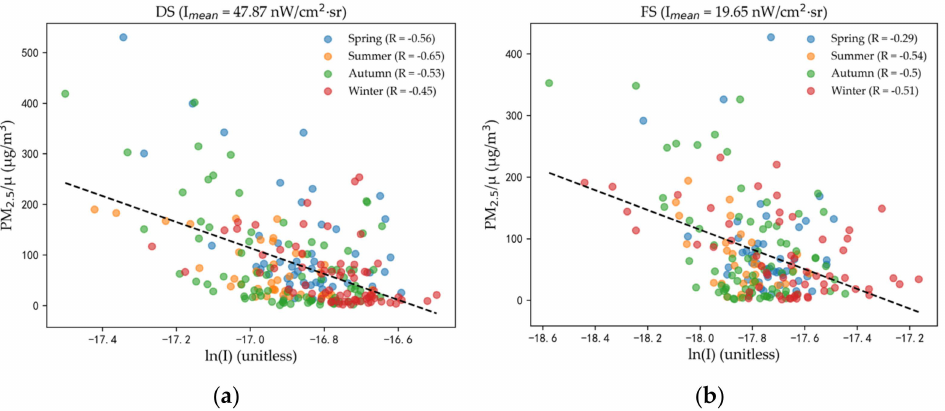
Figure 3. Scatter plots of PM 2.5 / µ and ln(I): ( a ) is the DS site while ( b ) is the FS site; I mean is the annual mean of radiance. The dashed line is the fit